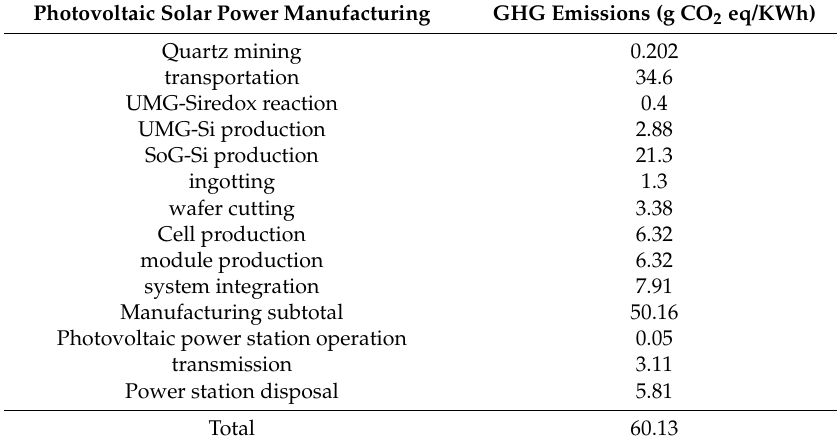
Table A6. Lifecycle greenhouse gas emissions of polycrystalline solar PV (g CO 2 eq/KWh). Photovoltaic Solar Power